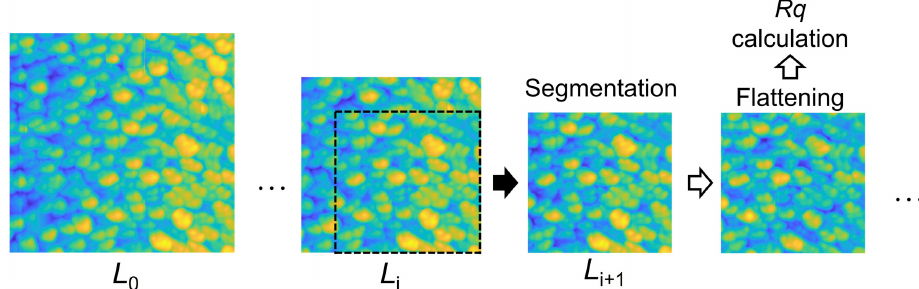
Figure 6. The procedure of RSE method including the segmentation, flatten, and calculation